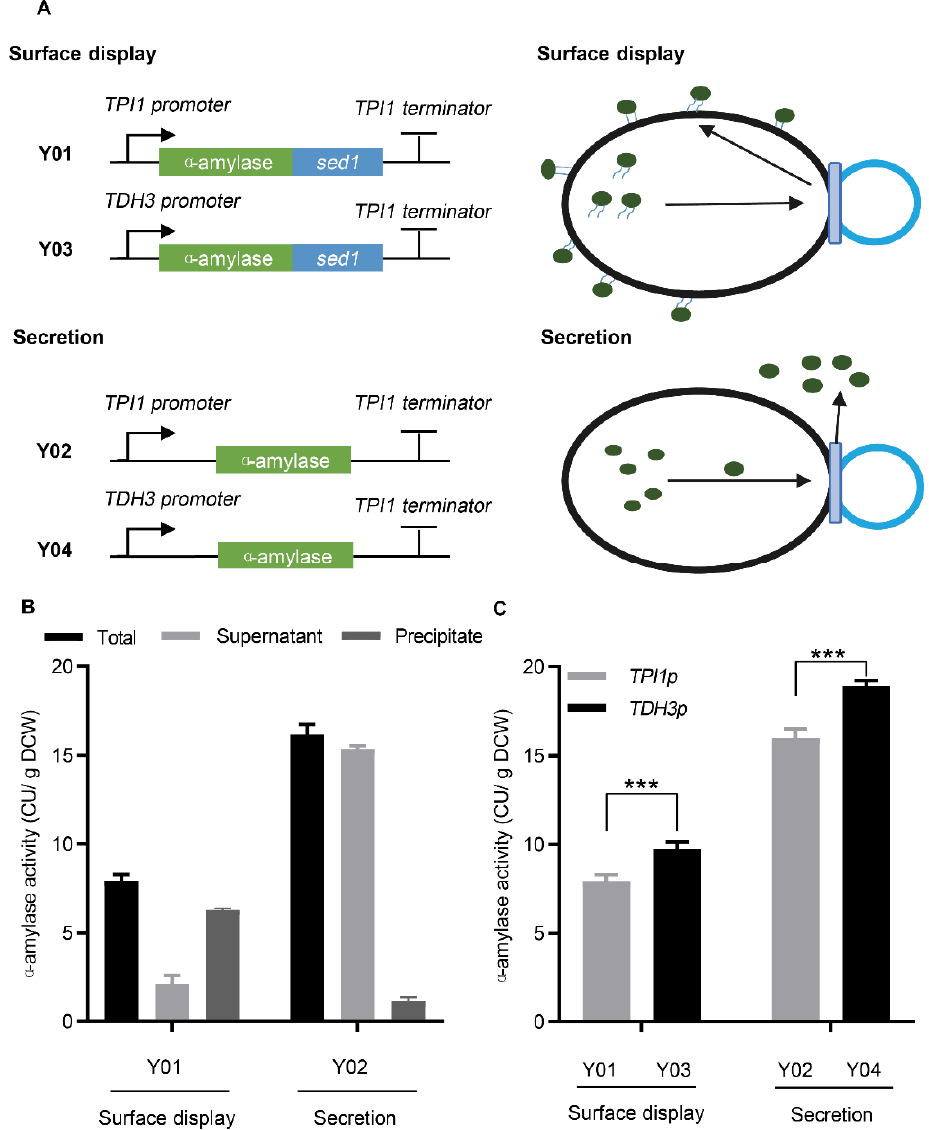
Figure 1. Expression of α -amylase in Saccharomyces cerevisiae . ( A ) Construction of α -amylase expression systems. ( B ) Activities of surface-displayed and secreted α -amylase. ( C ) The effect of promoters on the expression of α -amylase. All strains were cultivated in the YPD medium at 30 °C for 24 h. Data are mean ± SD from three independent experiments. The statistical significance of enzymatic assays was determined by a two − tailed homoscedastic (equal variance) t -test and three asterisks represents p < 0.005.